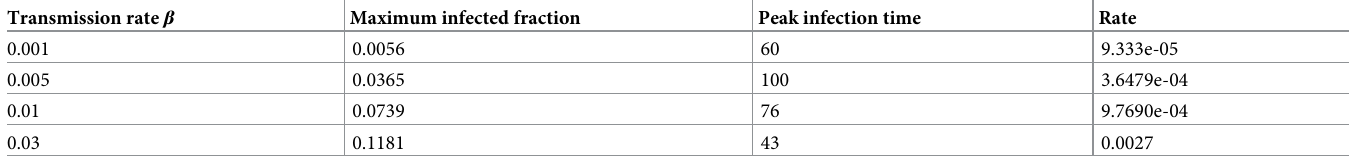
Table 3. Table shows maximum infected fractions of cows, peak infection time, and rate at which that maximum is attained for a heterogeneous network and a sin- gle infected cow in the Kabale municipality.